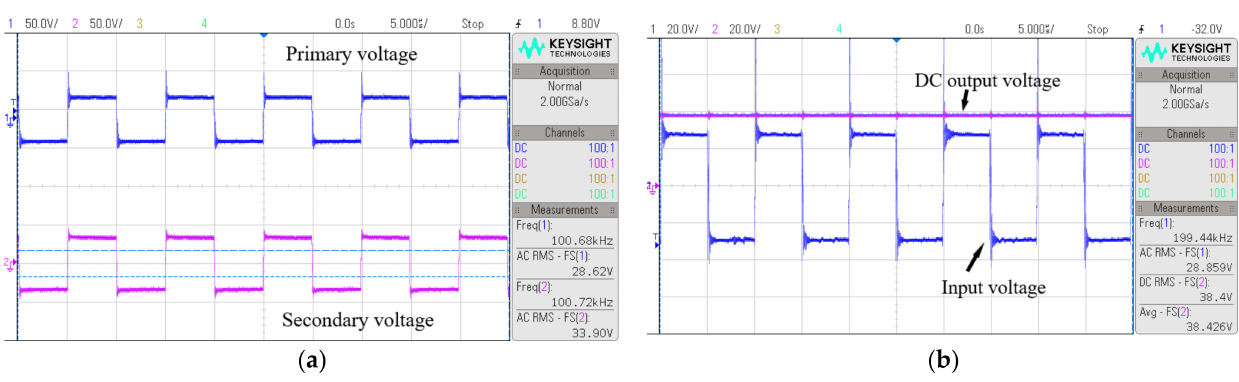
Figure 19. Waveform responses of the HF transformer: ( a ) Sinusoidal excitation; ( b ) Square-wave excitation.